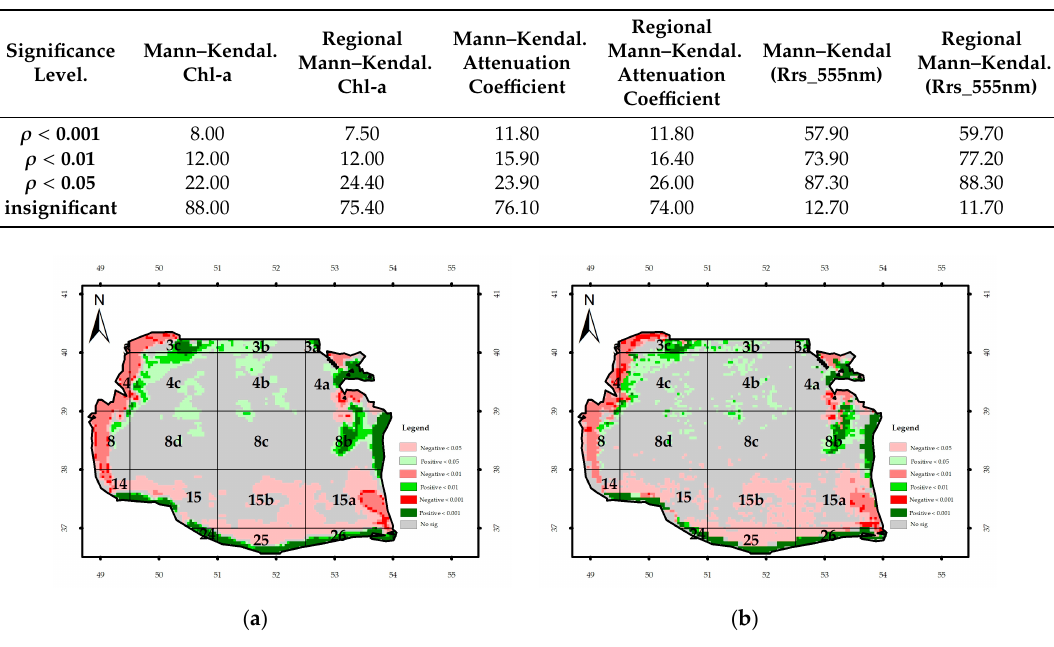
Figure A4. Significance of the monthly trend of the attenuation coefficient: ( a ) regional Mann–Kendal and ( b ) Mann–Kendal.